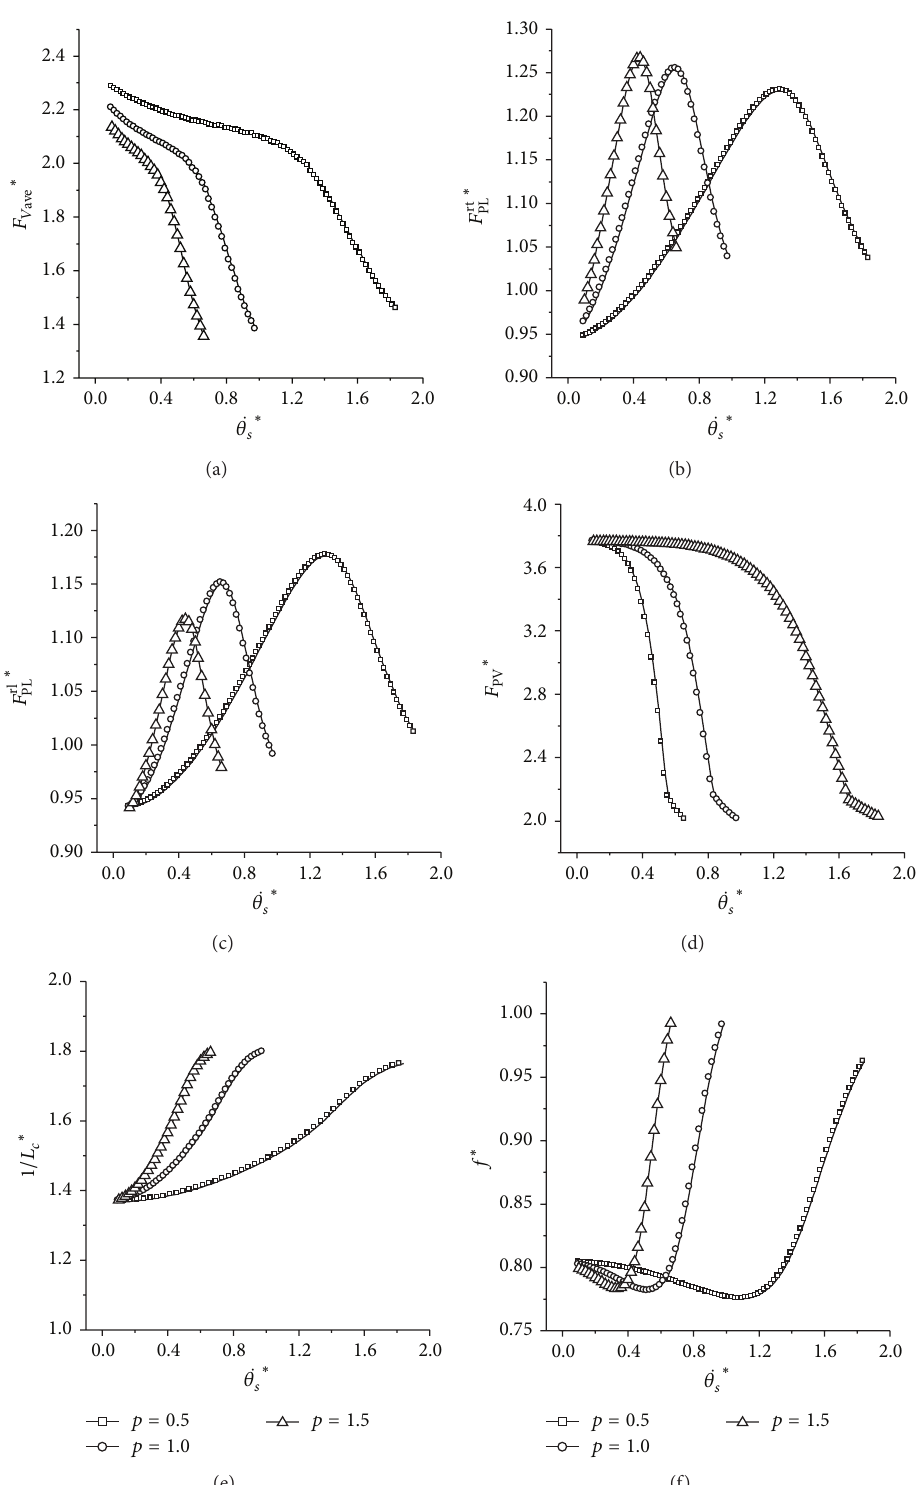
Figure 8: Influence of different body proportions on the transverse galloping model. (a) The average vertical force; (b) and (c) are the peak leg force for the rear trailing and the leading legs, respectively. (d) The peak ground reaction force; (e) the result of the indicator of the metabolic cost of transport; (f) the locomotion frequency. Initial conditions: 𝑦 ∗ 𝑠 = 1 , 𝜇 = 0.05 , V ∗ = 1.4 , and 𝑘 𝑎 = 1.0